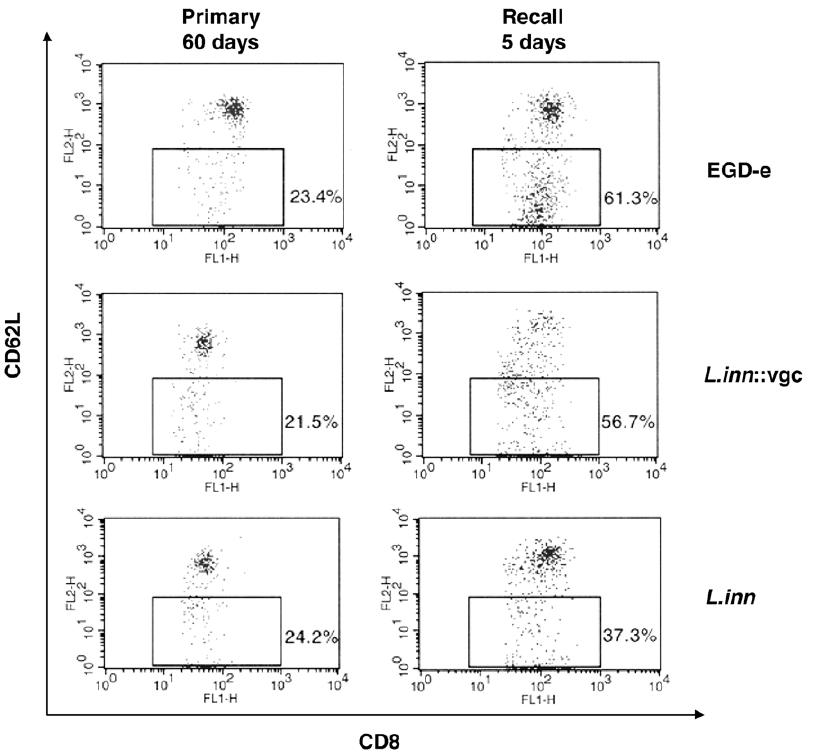
Figure 5. Expression levels of CD62L on CD8 + splenocytes following primary and recall infection with Lm , L.inn and the L.inn::vgc strain. Flow cytometry was performed on spleen cells, isolated from mice on day 60 after the primary infection or day 5 after the challenge. Cells were stained with FITC-labelled anti-Lyt-2 and biotinylated anti-CD62L. The binding of anti-CD62L on the cell surface was detected with PE- conjugated streptavidin. Numbers shown are gated CD8 + CD62 lo T cells and analyzed with CELLQuest software.